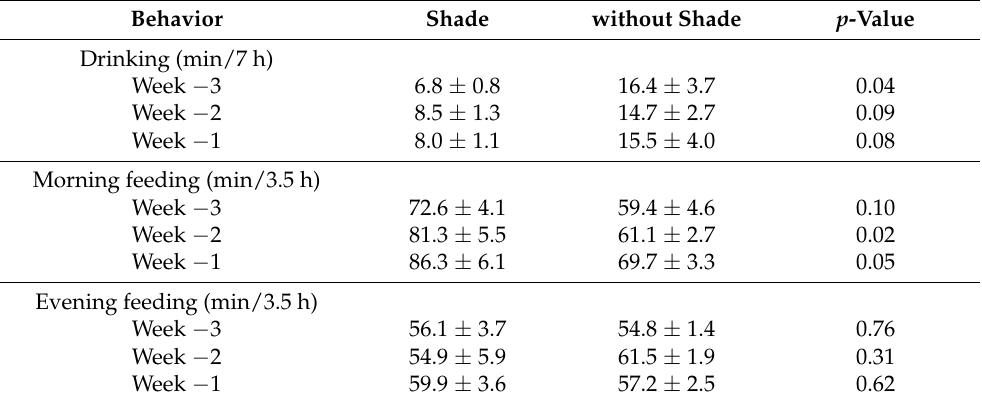
Table 3. Daily drinking time (1100–1759), morning feeding time (0830–1159 h), and evening feed- ing time (1800–2030 h) were observed in cows with access to shade ( n = 12) and without shade ( n = 11) in different weeks prior to calving (LSM ± SE). p -values are presented by prepartum week, between treatments.